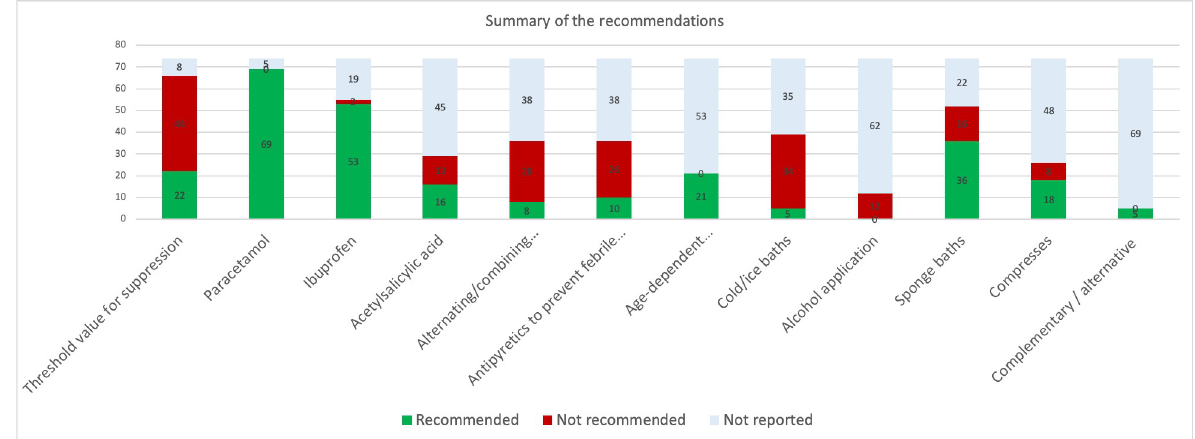
Fig 3. Summary of recommendations. Y-axis: numbers of guidelines